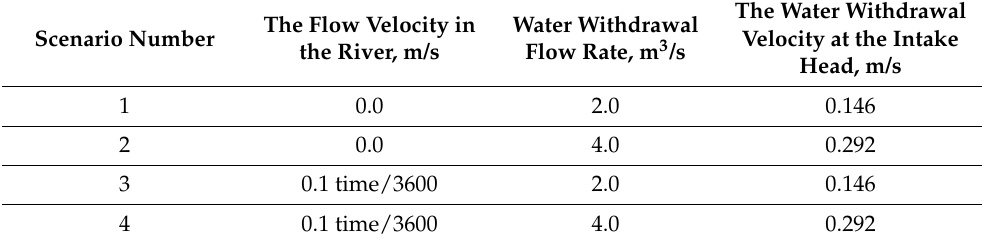
Table 1. Input data for